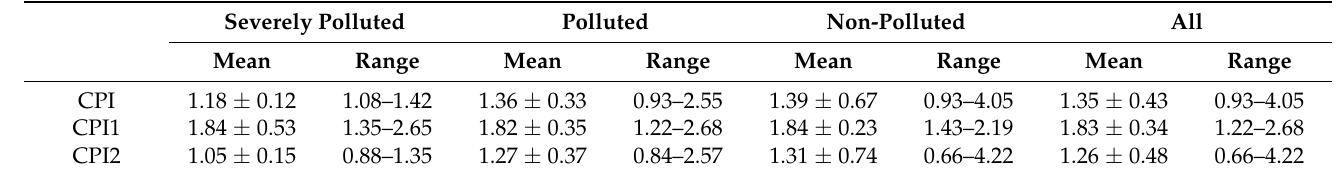
Table 2. CPI of n-alkanes associated with PM 2.5 during different polluted days.